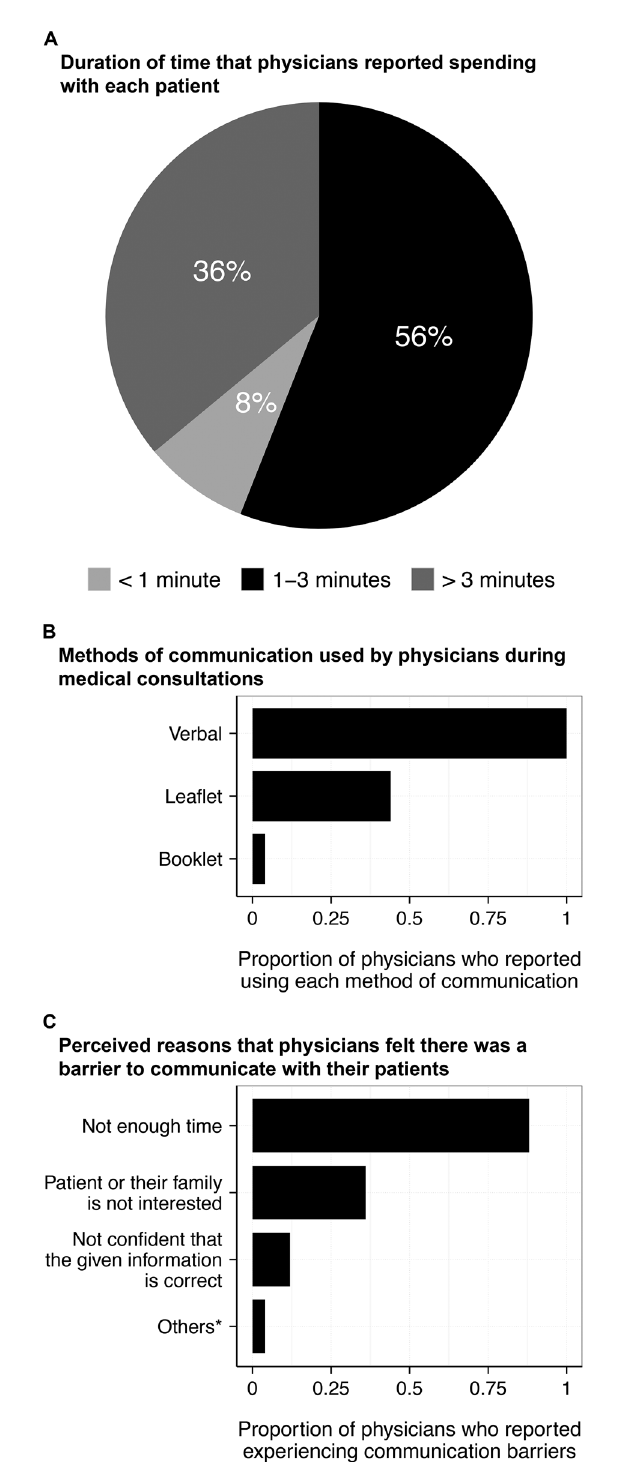
Fig 4. Duration, methods and perceived barriers of communication between physicians and patients during consultation. (A) The amount of time physicians report to spend with each of their patients to discuss their illness, during a standard medical consultation. (B) Modes of communication commonly used by physicians to explain DENV transmission and prevention to their patients. (C) Perceived barriers that physicians experience when discussing with dengue patients ’ families about DENV transmission and